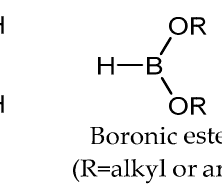
Figure 1. Organoboron compounds.